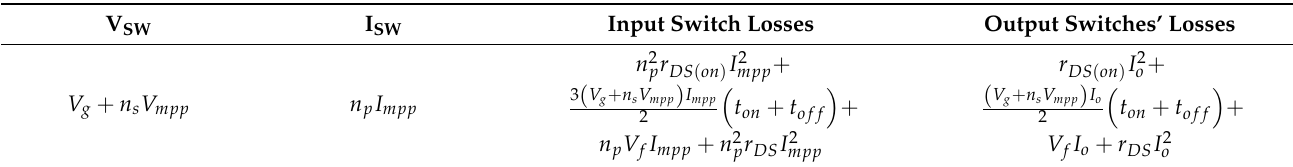
Figure 23. Central versus modular Cuk inverters. ( a ) Central Cuk inverter. ( b ) Modular Cuk inverter. Table 2. Power losses and switches stress of the central Cuk inverter.